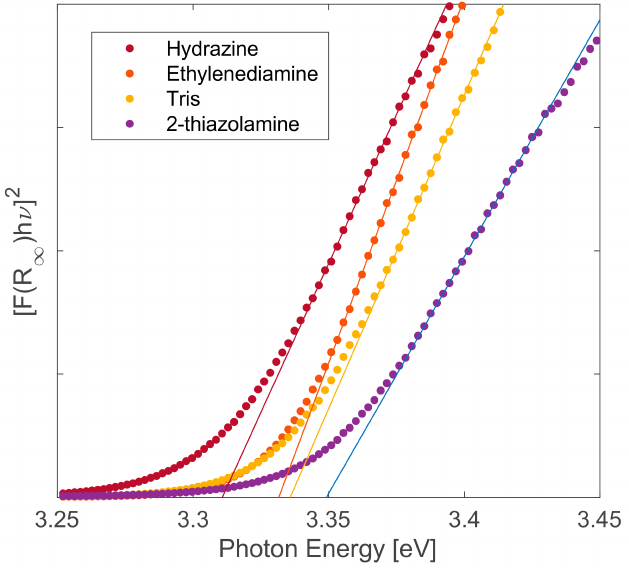
Figure 6. Kubelka–Munk transformed diffuse reflectance spectra of annealed ZnO powders prepared by rapid precipitation. The amine in the legend corresponds to the amine used during the synthesis of each